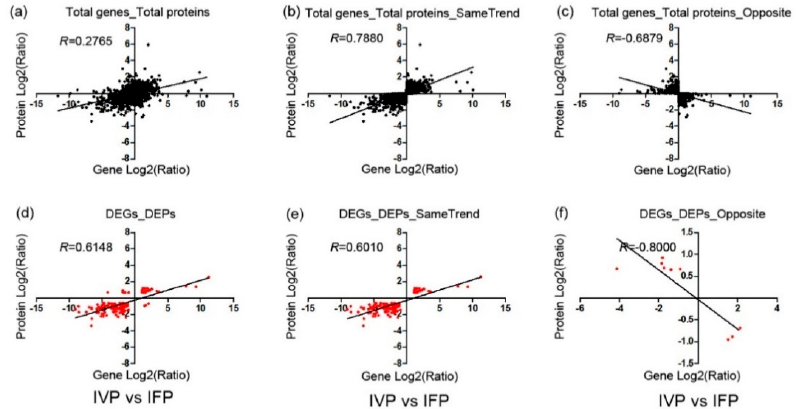
Figure 5. Concordance between changes in the abundance of mRNA and its encoded protein in IFP and IVP. R, Pearson correlations coefficient of the comparisons between fold changes of proteins and transcripts. ( a ) the expression levels of all the transcripts and their corresponding quantified proteins from IVP vs. IFP showed weak correlation (r = 0.2765). ( d ) a stronger correlation was discerned between the DEGs and their corresponding DEPs (r = 0.6148). The expression ratio of proteins and their corresponding mRNAs with the same or opposite trend (both upregulated or both downregulated) were also plotted, and higher positive or negative correlation was indicated ( b , c , e , f )